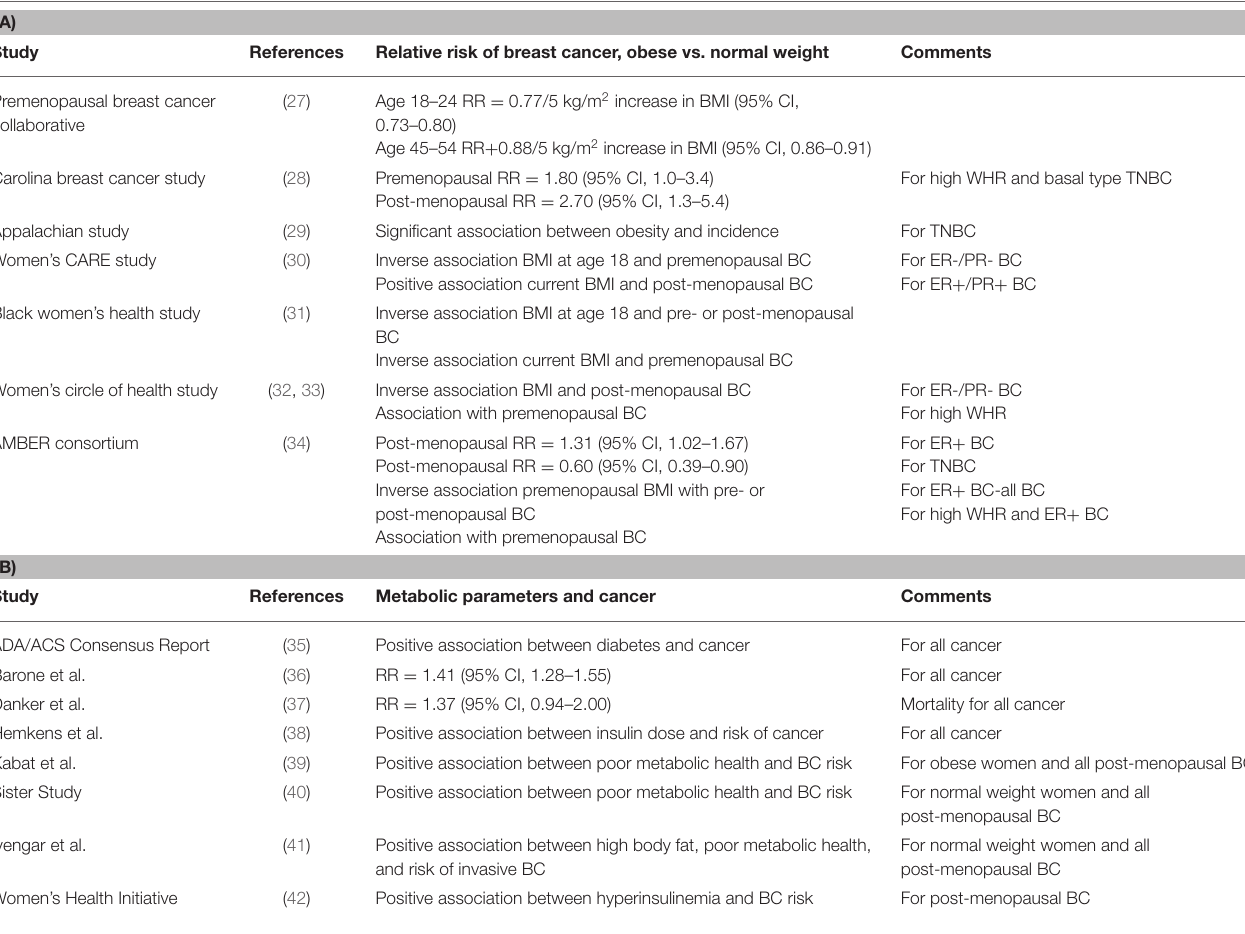
TABLE 1 | The association between: (A) Obesity and ER + or ER- Breast Cancer and (B) Metabolic Parameters and Cancer. (A) Relative risk of breast cancer, obese vs. normal